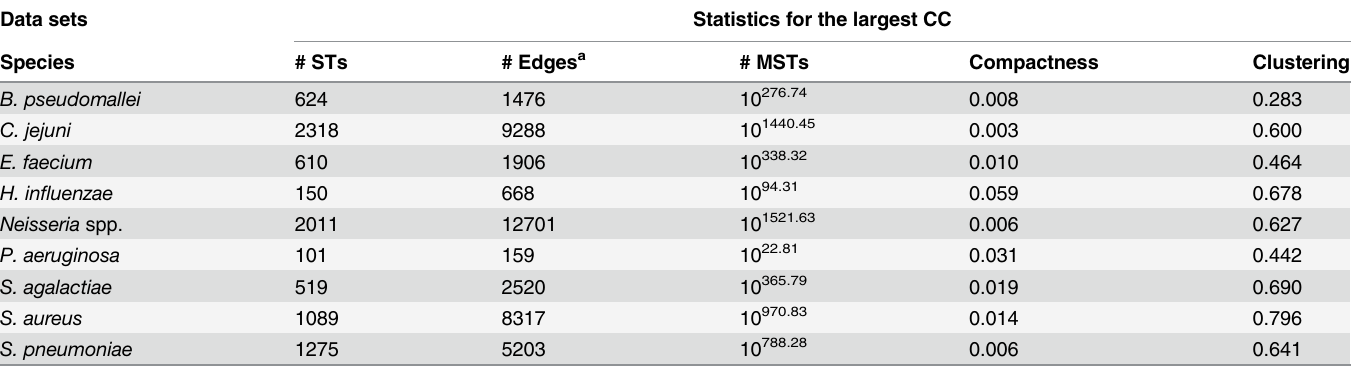
Table 1. Statistics relative to the largest CC linking STs at the SLV level. Columns represent the number of STs, the number of edges, the total number of possible MSTs and the compactness and clustering indexes. The compactness index quanti fi es how directly connected individuals in the network are. The clustering index quanti fi es how close the neighbors of a given individual are from a complete graph (clique). Each index is an average after computing the index individually for each ST. Data sets